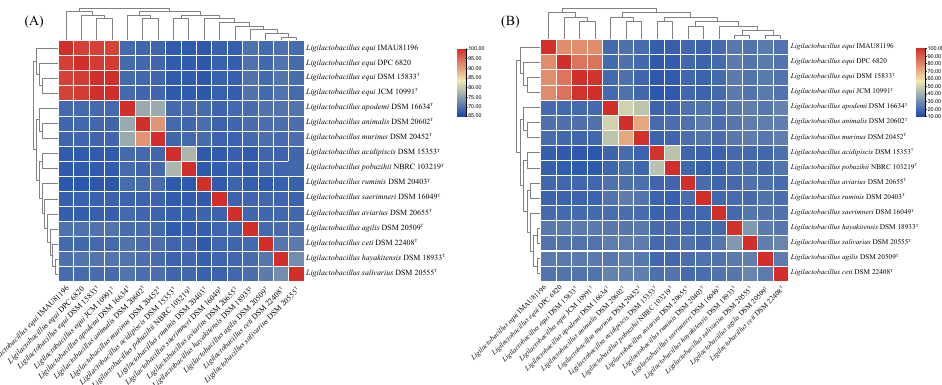
Figure 1. ANI analysis ( A ) and TNI analysis ( B ) of type strains from the genus Ligilactobacillus